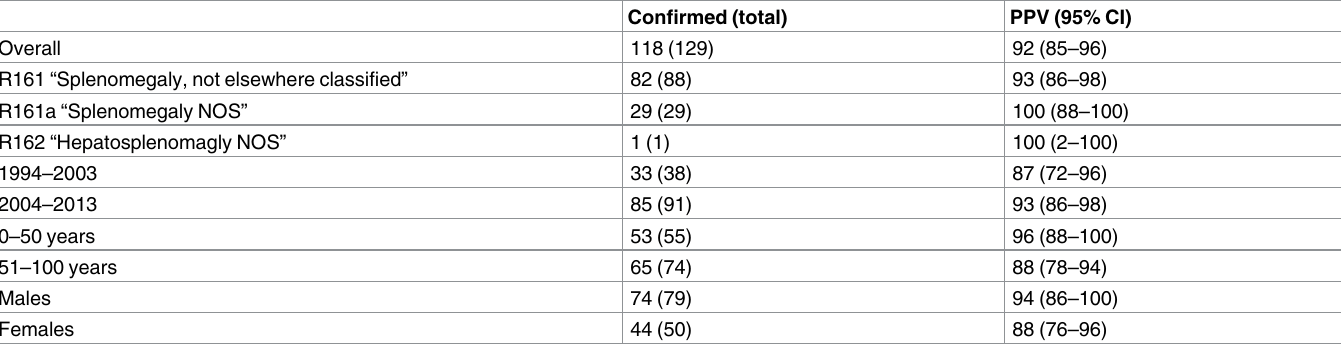
Table 1. Positive predictive values.